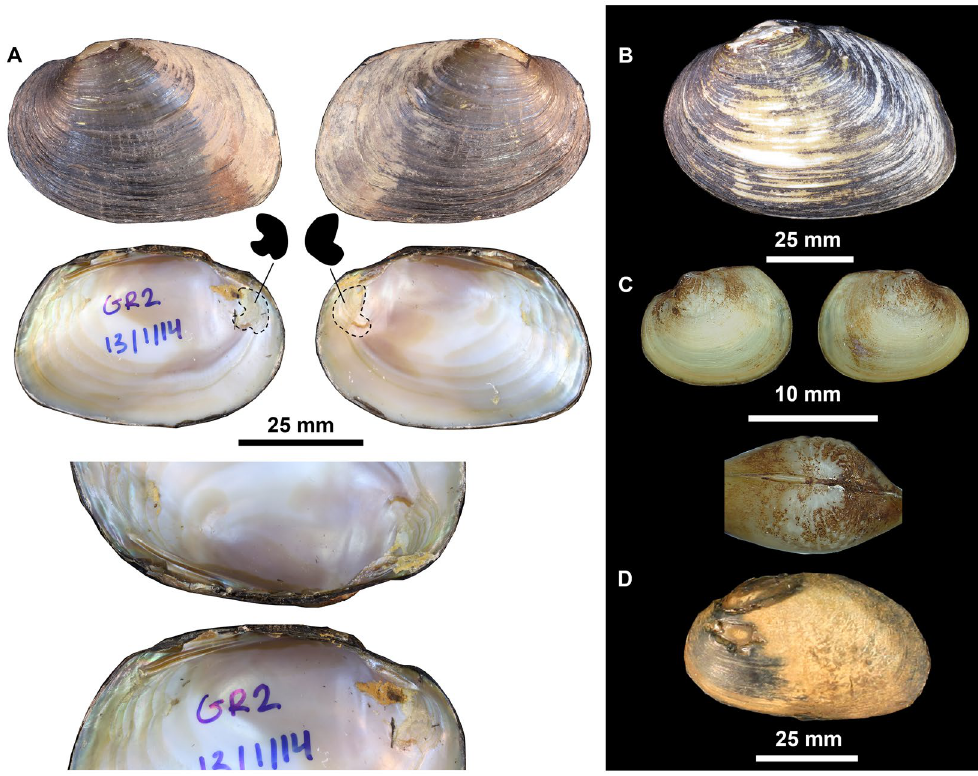
Figure 7. Westralunio inbisi inbisi subsp. nov., ( A ) Paratype: Goodga River, Western Australia, WAM S5620. Detail of fusion in anterior muscle scars from either valve represented by dashed lines and black polygons. Bottom image showing detail of hinge teeth. Photos by Corey Whisson. ( B ) Holotype: Goodga River, Western Australia, WAM S82756. Photo by Corey Whisson. ( C ) Valves and detail of sculptured umbo of a juvenile, Lake Yeagarup, Western Australia, WAM S82697. Photo by Dr Michael W. Klunzinger. ( D ) Westralunio inbisi meridiemus subsp. nov. Holotype: Margaret River, Western Australia, WAM S56235. Photo by Corey